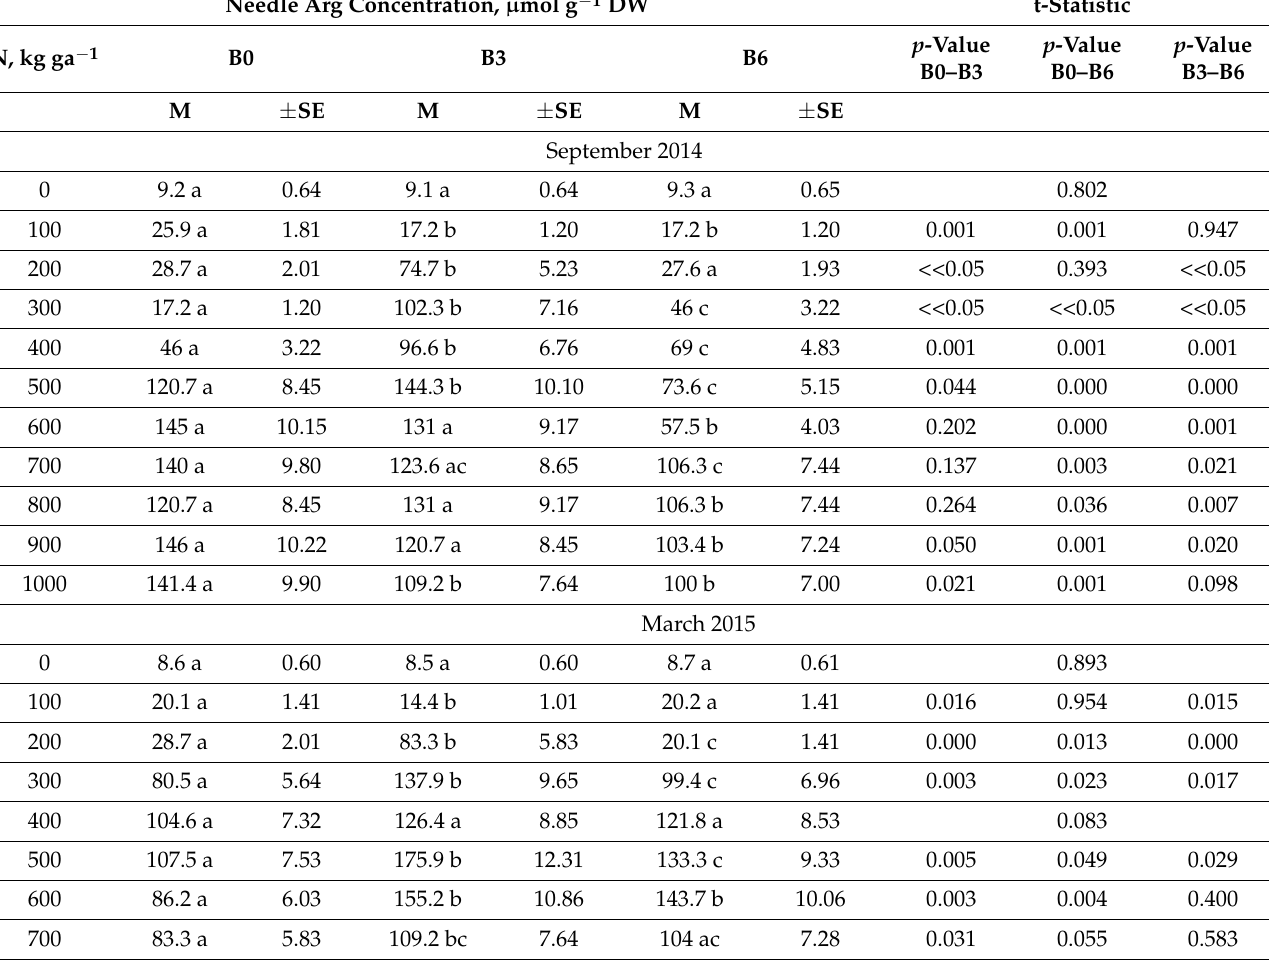
Table 5. Two-sample t -test analysis with equal variances ( α = 0.05) was applied to estimate signifi- cance of post hoc differences between treatments of different B-fertilized doses at the same levels of N on arginine content ( µ mol g − 1 ) in one-year-old needles of 16-year old Pinus sylvestris L. in September 2014 and March 2015. Doses of N were from 0 to 1000 kg ha − 1 with a 100 kg ha − 1 step (N0, N1, . . . N10) and B doses were 0 (B0), 3.0 (B3), and 6.0 (B6) kg ha − 1 . Different lower case letters (a, b, or c) beside means indicate significant post hoc differences between treatments (Tukey’s test). ( p =